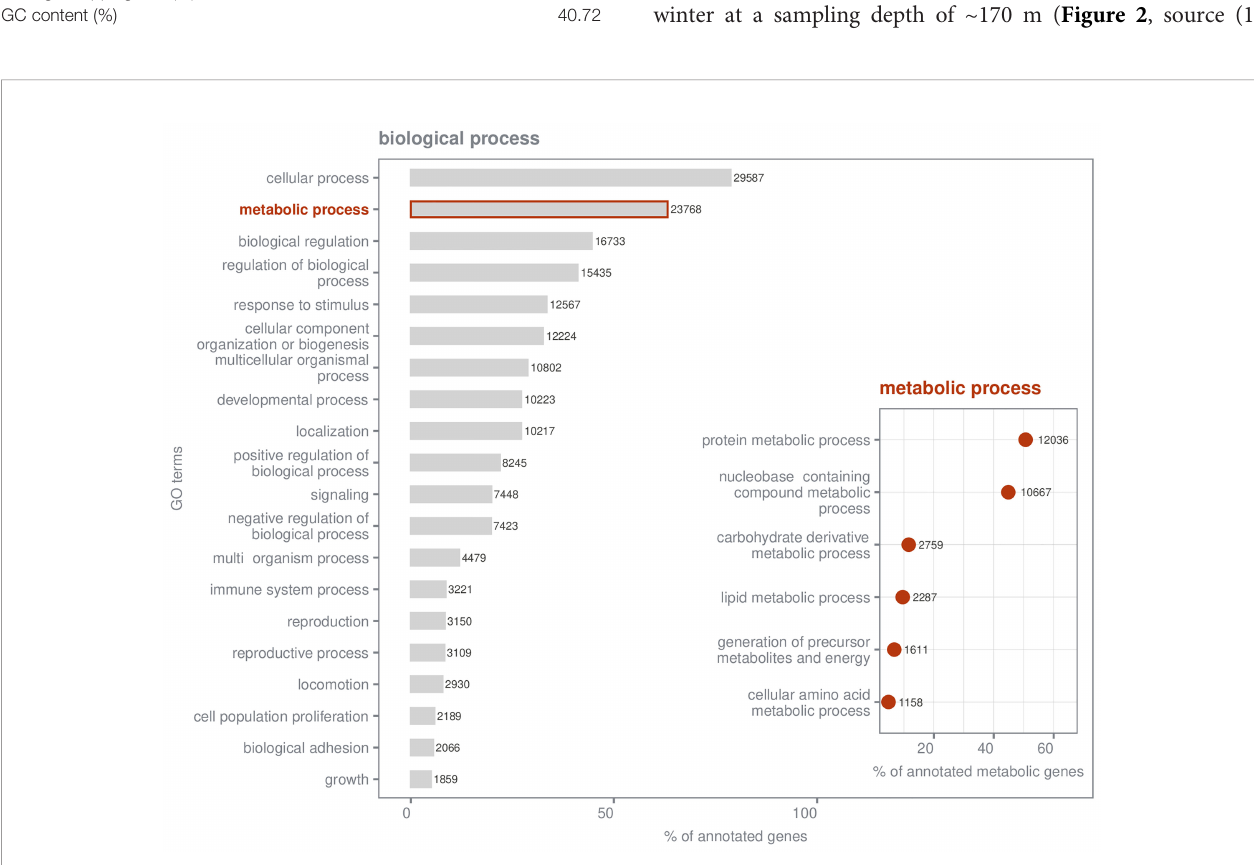
FIGURE 3 | Gene ontology (GO) term distribution of annotated genes present in the transcriptome. Numbers next to the bar/dot indicate the absolute number of genes assigned to each category, while the x- axis indicates the respective percentage. Classi fi cation of biological processes of all annotated genes in the reference transcriptome (=37,601), summarized at second level, is shown. Only categories that were assigned to at least 4% of all annotated genes are displayed. A classi fi cation of genes within metabolic processes (23,768 in total) is also provided, summarized at the fourth level of biological